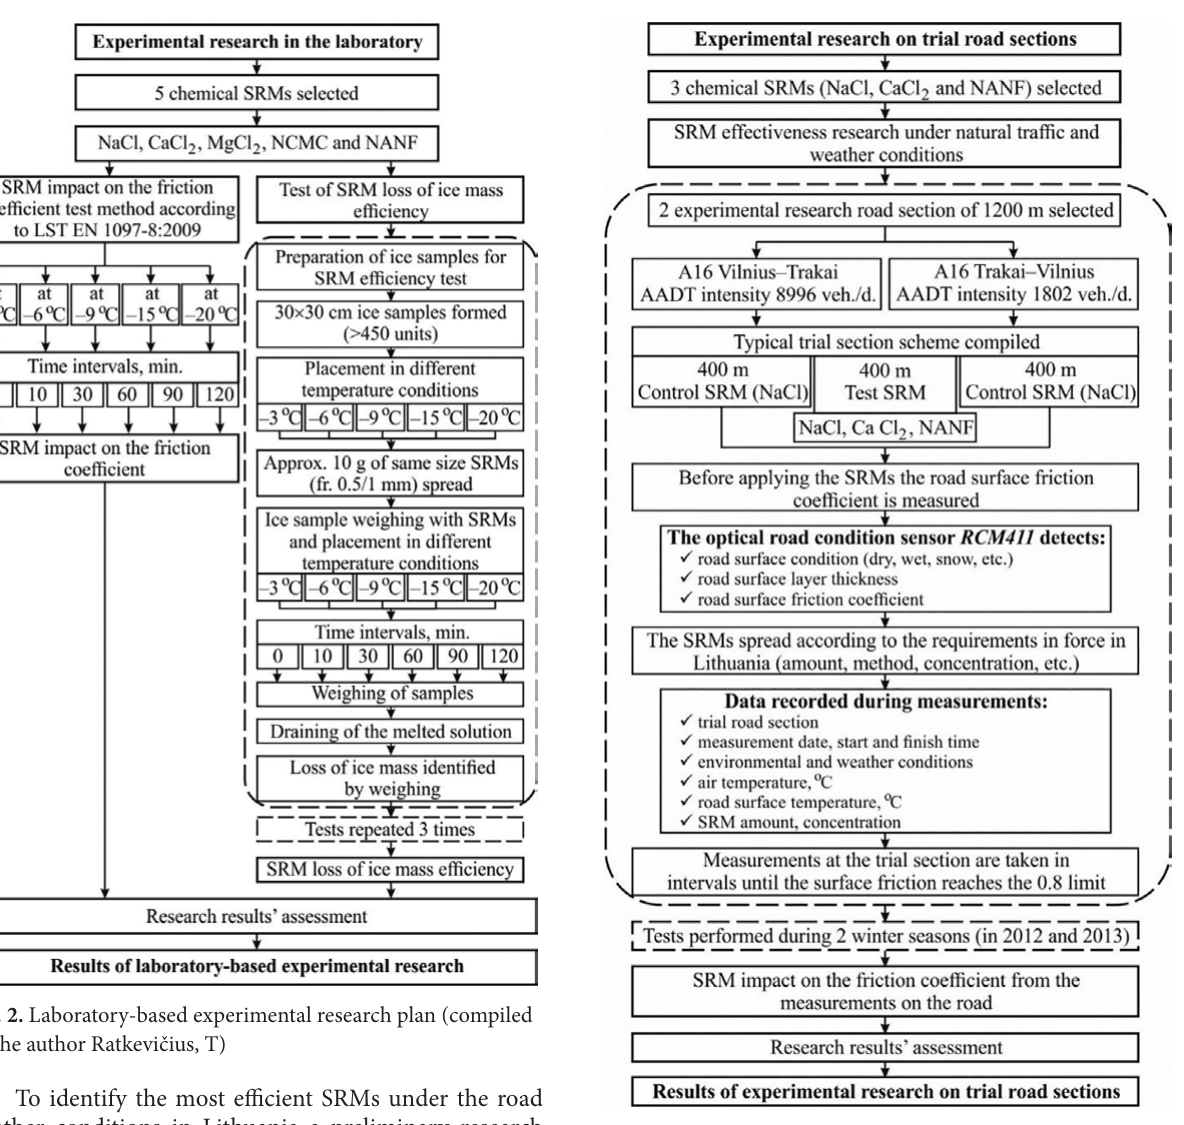
Fig. 3. Plan of experimental research on trial road sections (compiled by the author Ratkevičius, T) Table 1. The summarised total slipperiness reducing materials effectiveness research